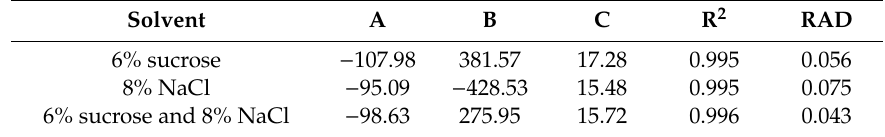
Parameters of the Apelblat equation for β -Cyclodextrin in the sucrose, NaCl, and mixed